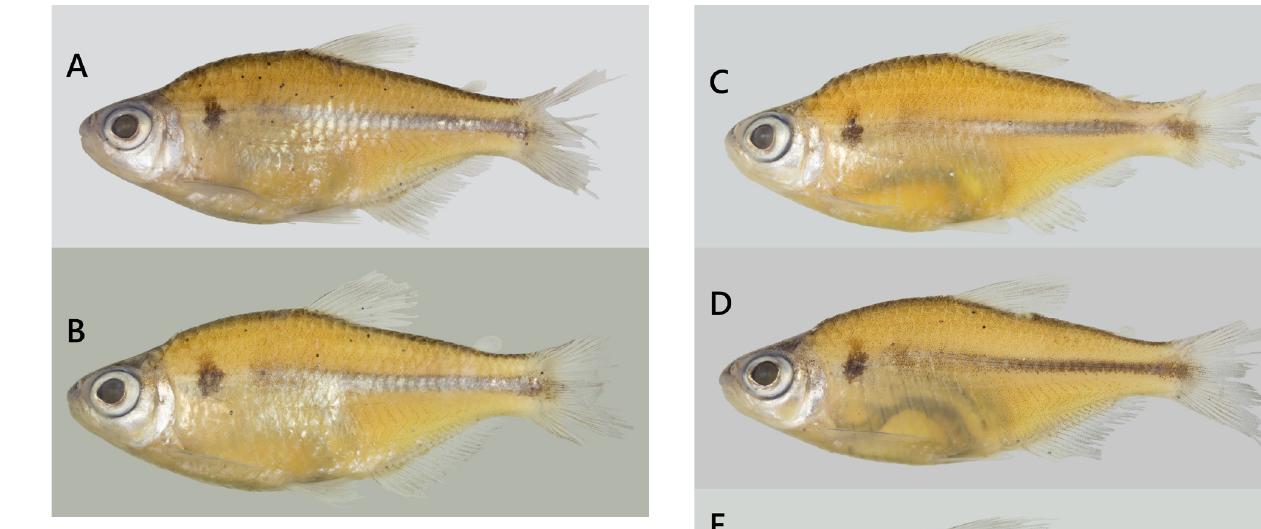
FIGURE 7 | Knodus obolus , paratypes. Ontogenetic and polymorphic variation of the body shape and colour patterns. All from the ribeirão Dois Irmãos drainage, upper Tocantins basin in Pirenópolis, Goiás State, Brazil. A. NUP 22668, 56.9 mm SL. B. NUP 22668, 53.2 mm SL. C. NUP 22668, 49.6 mm SL. D. NUP 22668, 45.0 mm SL. E. NUP 22668, 33.1 mm